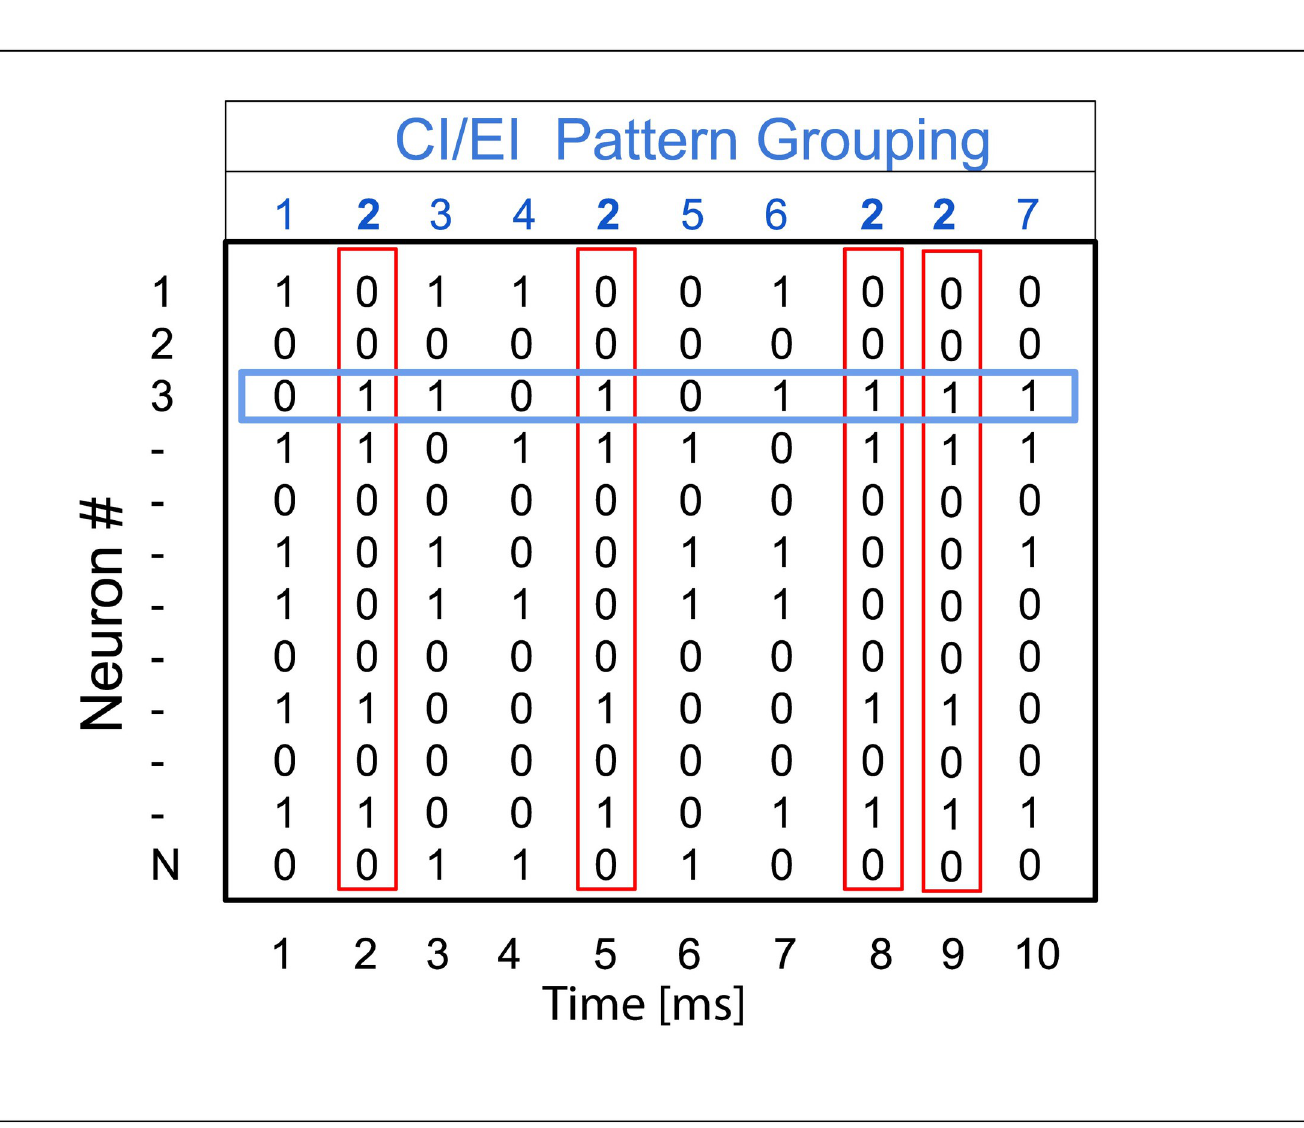
Fig 9. Binned spike patterns for complexity and integration measures. To compute entropy metrics complexity (C(X)) and integration (I(X)), spike trains were binned in 1 ms bins. H(X) in Eqs (16)/(17)is computed according to unique patterns associated with column vectors (red vectors) while H(X i ) is the entropy associated with a single neuron spike train (blue